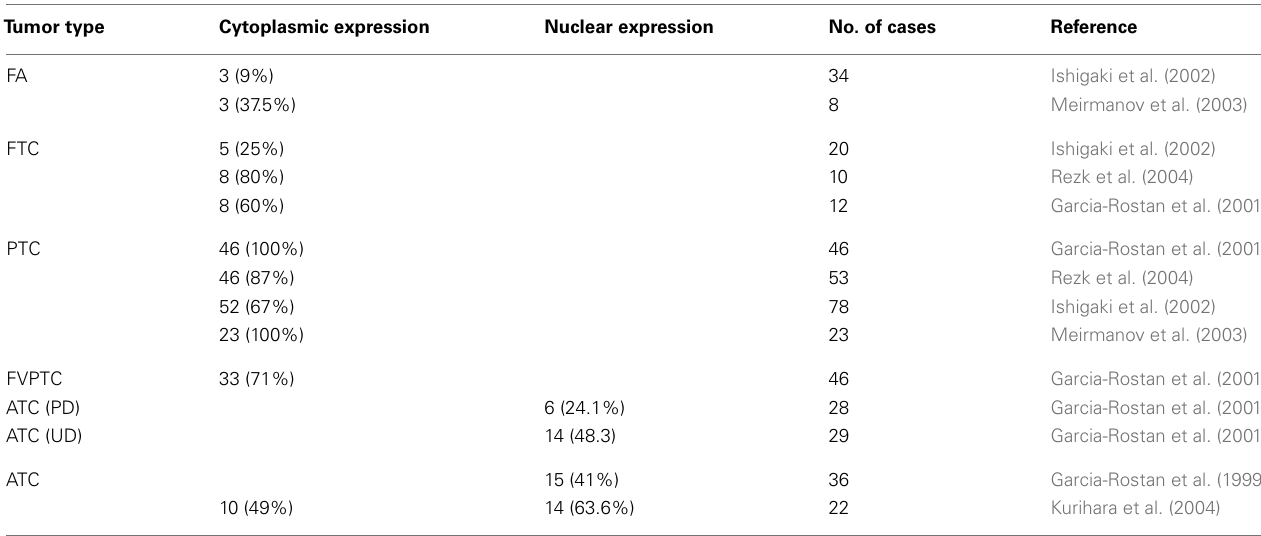
Table 3 | Localization of β -catenin in thyroid